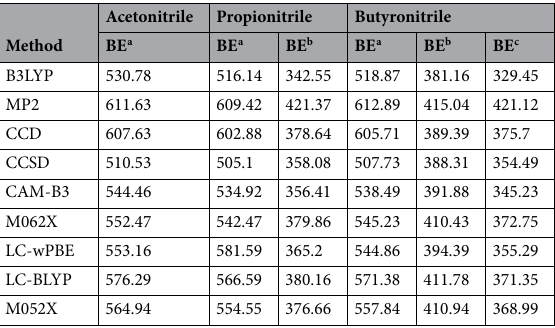
Table 1. Binding energies (C–C bond) calculated for the studied organic nitriles (kJ/mol). *BE a : C 1 –C 2 Binding energy a . *BE b : C 2 –C 3 (C 3 –C 4 ) Binding energy b . *BE c : C 3 –C 2 Binding energy c . *Basis set: 6-311++ G(d,p).